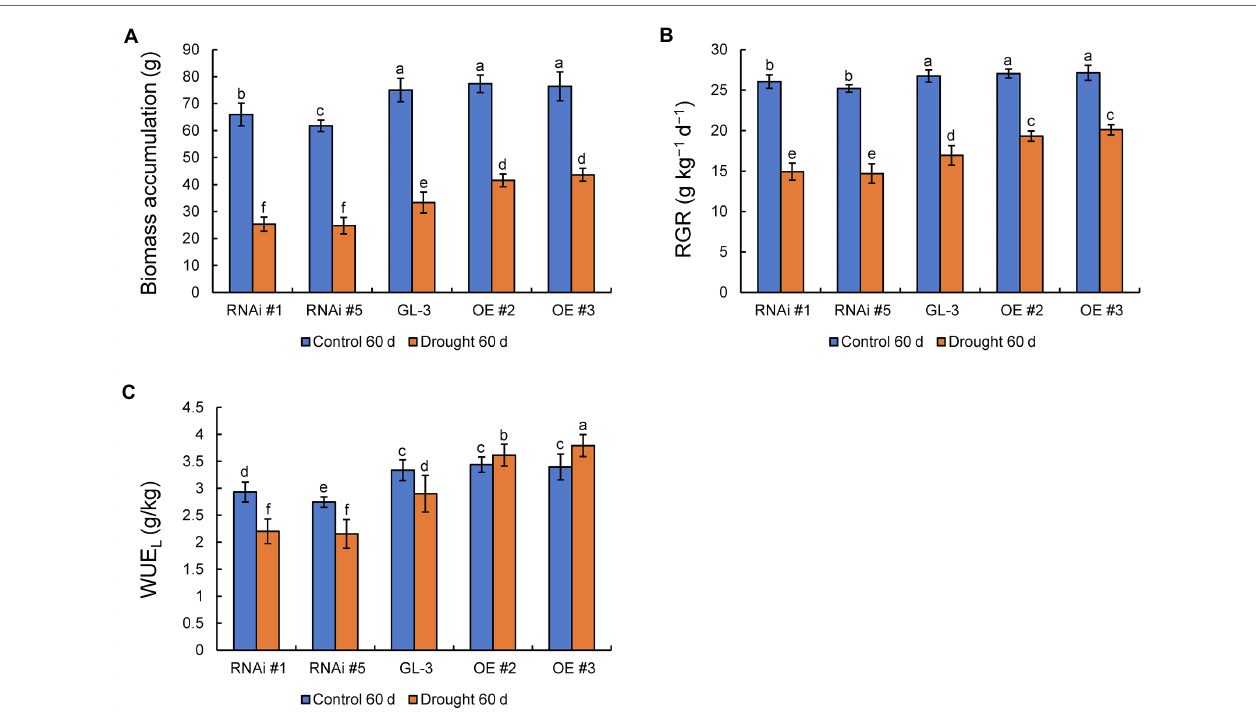
FIGURE 2 | Biomass accumulation, RGR, and long-term WUE (WUE L ) of GL-3 and MdHB-7 transgenic plants after 0 and 60 days under moderate soil water deficit conditions. (A) Biomass (plant dry weight). (B) Relative growth rate (RGR). (C) WUE L . Data are means ± SD ( n = 18; 18 plants from each line). Different letters indicate significant differences between GL-3 and transgenic apple plants based on one-way ANOVA and Tukey’s multiple range test ( p <